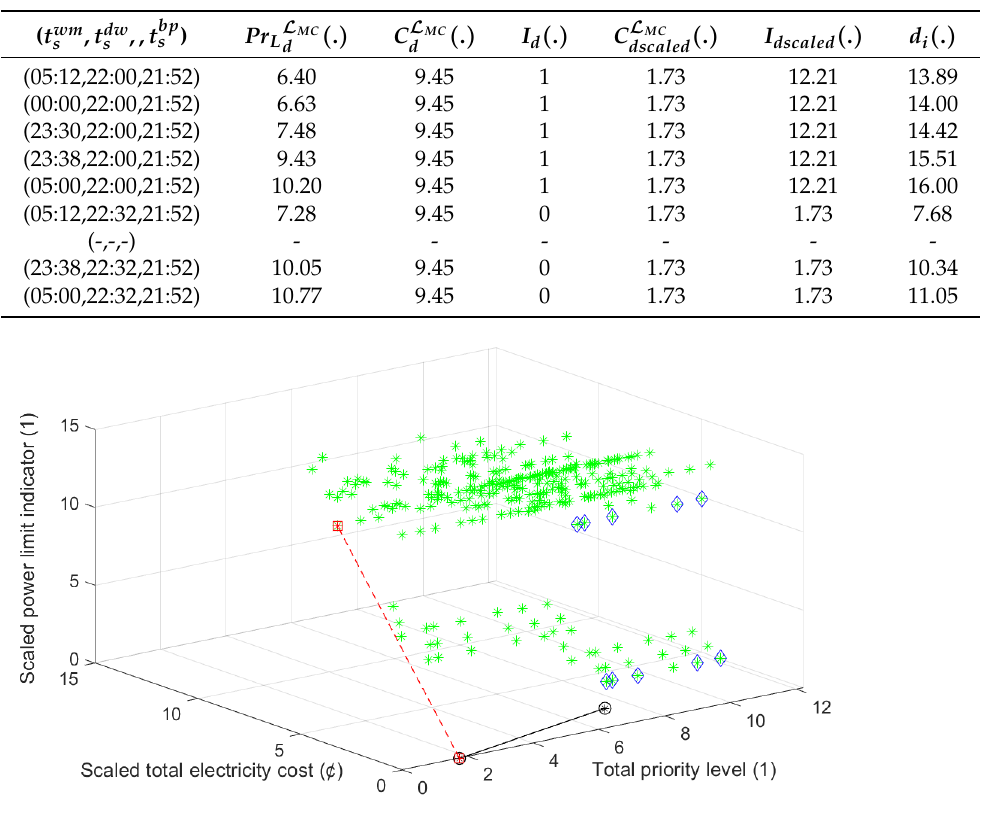
Figure 6. Three-axis chart for possible triplets of ( t wm s , t dw s , t bp s ) for Scenario 1.